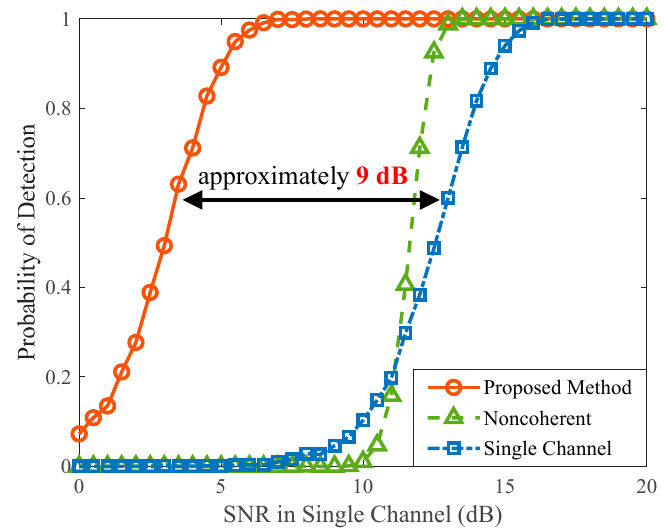
Figure 16. Detection performance utilizing CFAR algorithm with 1000 Monte Carlo simulations.